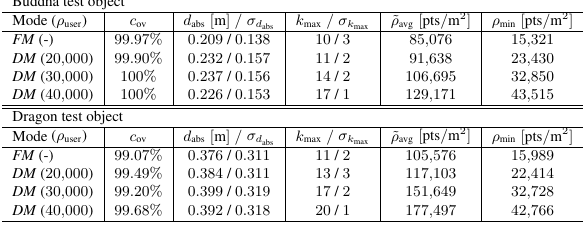
Figure 2. Test of the three most important hyperparameters (num- ber of nodes, number of training samples and number of maxi- mum training epochs) on runtime influence. Every hyperparam- eter run through ten tests, indicated on the x -axis, in the value range as displayed. During each run, the other two hyperparame- ters are set on a constant mid-range value, respectively. Figure 2 (dashed-dot line with square markers) clearly reveals the effect on the runtime if the number of network nodes N increases. Therefore, we use for the experiments the smallest number of nodes which can still represent the topology of the input data.